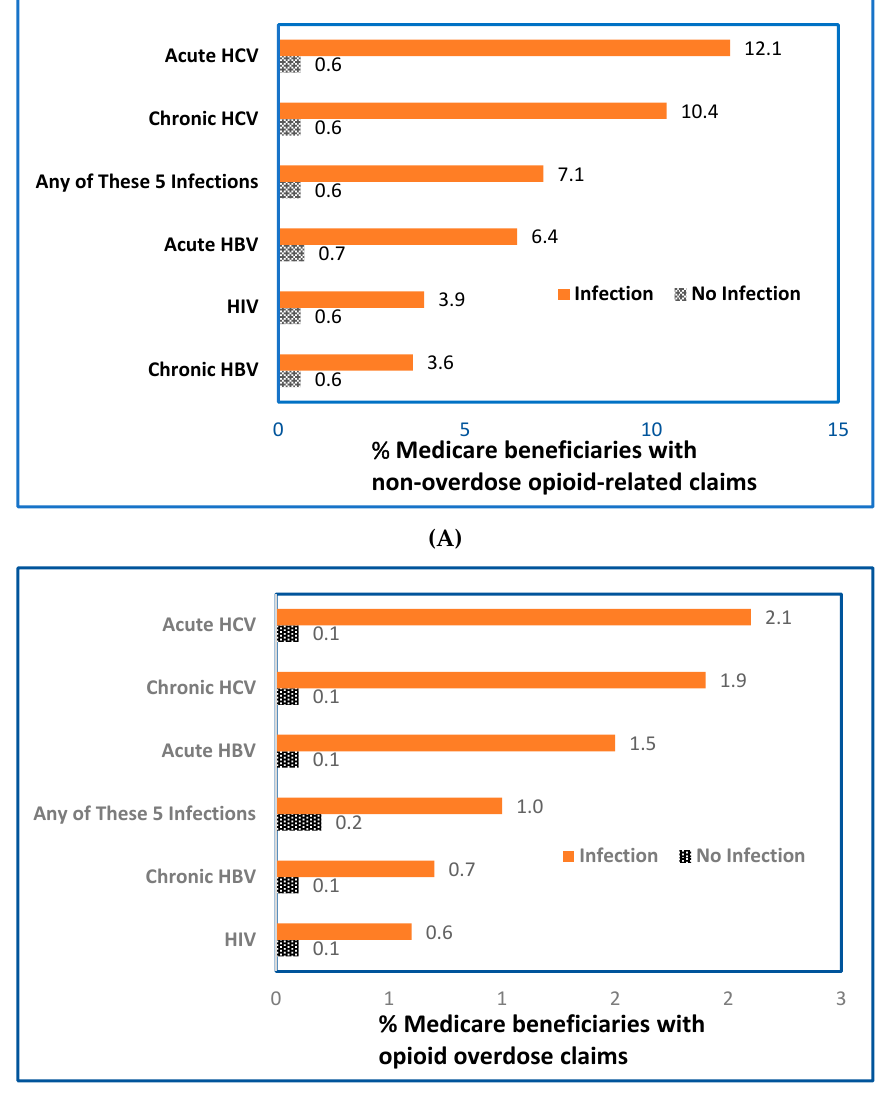
Figure 1. Percentage of Medicare beneficiaries with opioid-related claims among beneficiaries without ( A ) or with ( B ) claims for HIV, HBV, or HCV, United States, 2015; ( n = 40.6 million beneficiaries with FFS claims for non-overdose opioid-related diagnoses). Abbreviations: FFS, fee-for service, HBV, hepatitis B virus; HCV, hepatitis C virus, HIV, human immunodeficiency virus. Data were calculated from 40.6 million beneficiaries with fee-for-service claims from Medicare administrative enrollment and claims data collected by the Centers for Medicare and Medicaid Services during 2015. Each beneficiary was